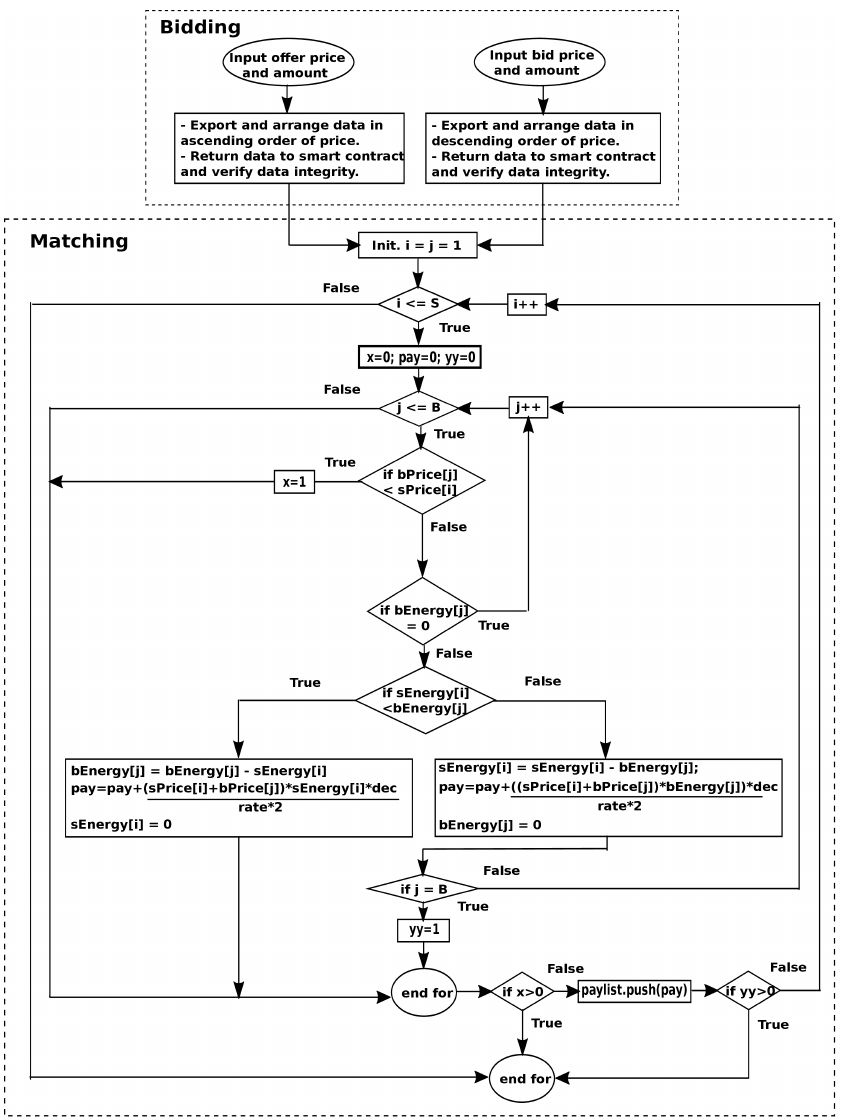
Figure 3. Systematic smart contract-based reserve trading scheme (smart contract B). Reserve sellers submit their offer to the smart contract (F3). Offers are sent out to be re-ordered and returned to the contract (F4). Buyers submit their demand (F5), as well as make payment (F6), to the smart contract which then pays successful sellers (F7).